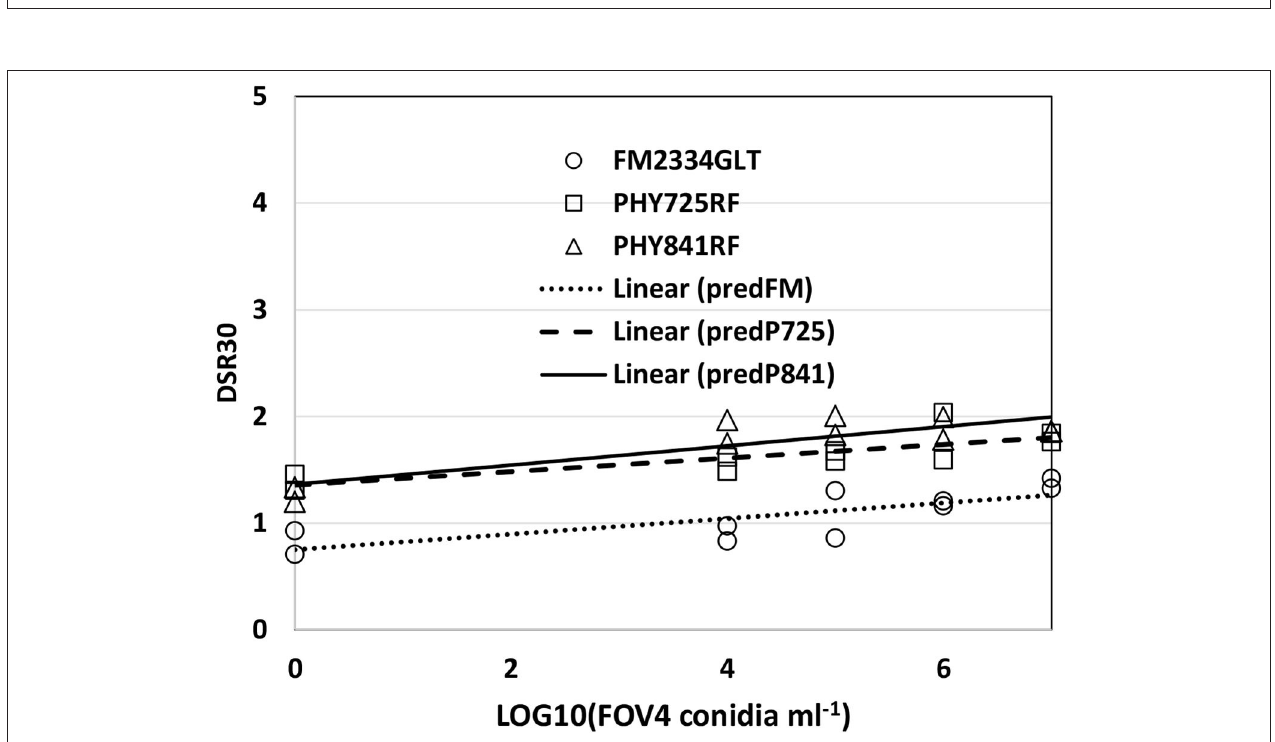
FIGURE 3 | FOV4 symptoms at 30 days after inoculation, as a function of inoculum density in 2020. Plants were rated on a 0–5 scale with 5 being plant death. PredFM, predP725, and P841 are the linear relationship predicted for FM 2334GLT, PHY 725 RF, and PHY 841 RF, respectively.